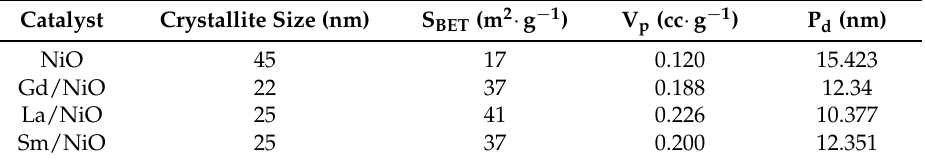
Figure 2. XRD diffractograms of the calcined Ni ‐ oxalate ( a ); Gd/Ni ‐ oxalate ( b ); La/Ni ‐ oxalate ( c ); and Sm/Ni ‐ oxalate ( d ).